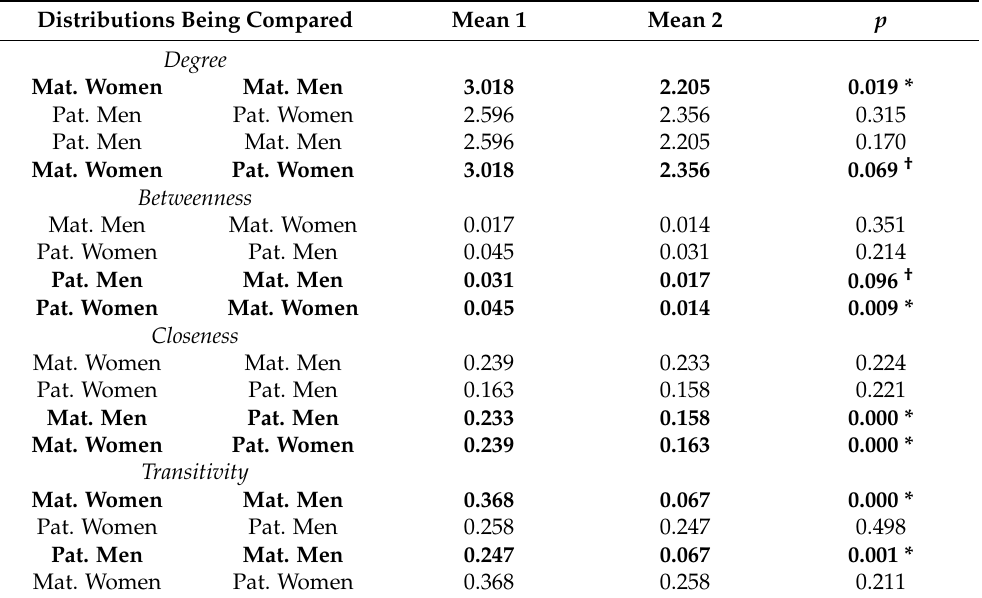
Table 2. Results of permutation tests comparing degree, betweenness, closeness, and transitivity distributions for patrilineal (pat.) and matrilineal (mat.) Mosuo respondents. Distributions Being Compared Mean 1 Mean 2 p Degree Mat.